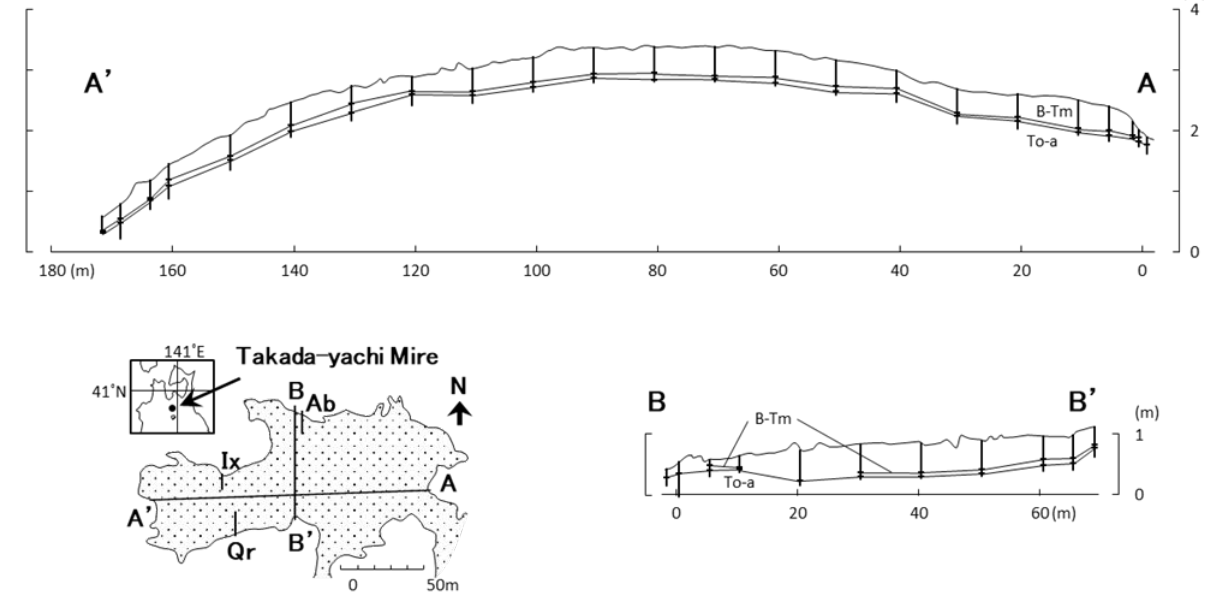
Figure 1. The Takada-yachi Mire, northern Japan, showing the profiles with two tephras (To-a and B-Tm) and the locations of sampling plots along the two major transect lines (Line A and Line